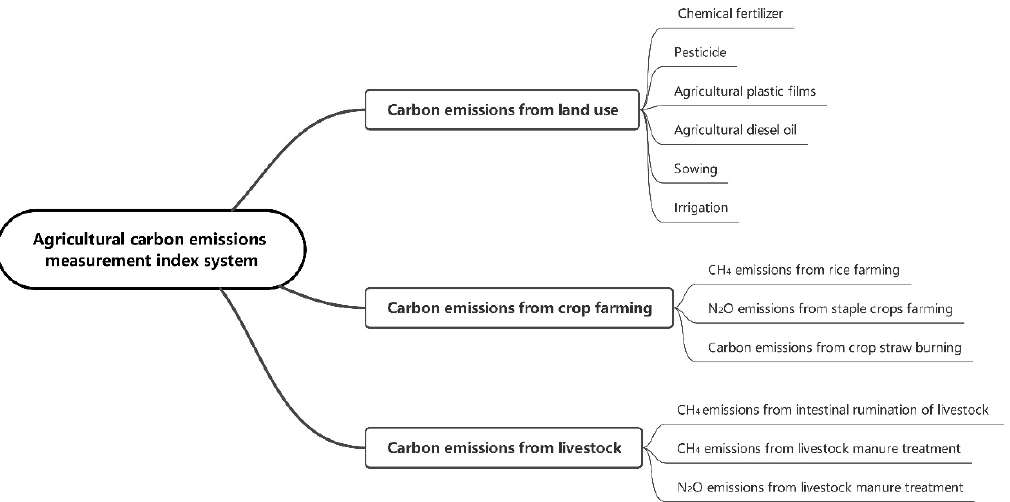
Figure 2. Evaluation index system of agricultural carbon emissions. Note: Only methane emissions from rice were considered in this paper, as rice is the most significant source of methane emissions from crop cultivation, while other crops are largely negligible [17]. Table 1. Evaluation index system of agricultural modernization